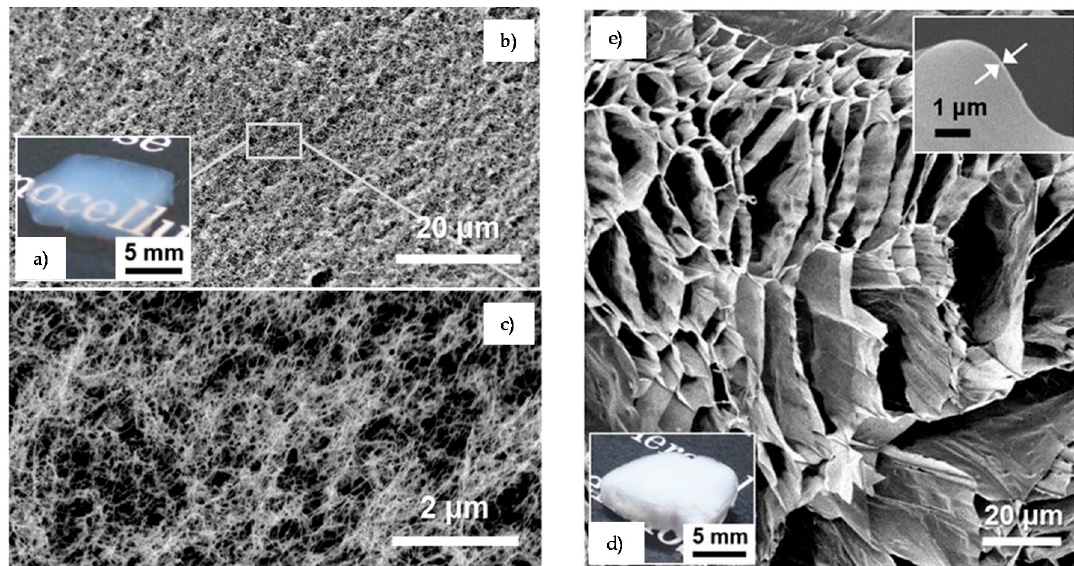
Figure 1. ( a ) Physical appearance of a cellulose aerogel; ( b , c ) Scanning electron microscopy images of a cellulose aerogel at different magnifications; ( d ) Physical appearance of a cellulose foam; ( e ) Scanning electron microscopy images of a cellulose foam. Reproduced from Sakai et al. [9],